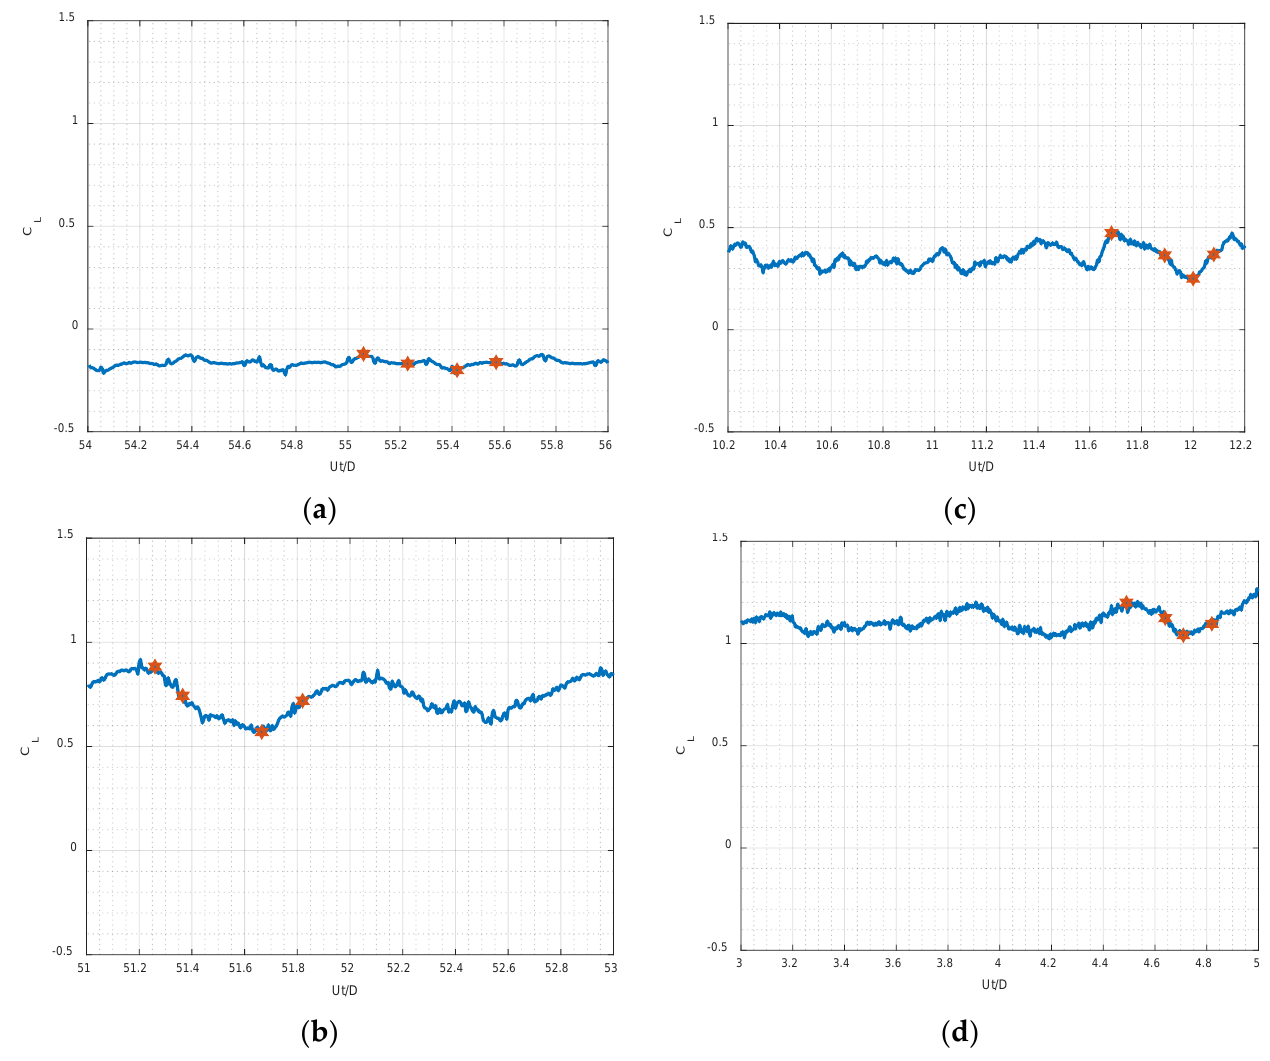
Figure 5. Segments of lift force coefficient time histories simulated using VPM for NACA64 at ( a ) α = 0 ◦ , Re C = 4000, ( b ) α = 10 ◦ , Re C = 4000, ( c ) α = 0 ◦ , Re C = 60,000, and ( d ) α = 10 ◦ , Re C = 60,000. To examine the effects in detail, instantaneous flow fields and surface pressures are examined for α = 0 ◦ and 10 ◦ . For α = 0 ◦ , Figure 6 shows the flow fields at instants Ut / D = 55.06 and 11.68 for Re C = 4000 and 60,000, respectively, which correspond to the instants labeled by the first red stars in Figure 5c. For the low Reynolds number case, the vorticity (Figure 6a) develops from the windward portion of the body wall, indicating the growth of laminar boundary layers in this region. At approximately 60% of the chord, the flow and the vorticity separate, feeding into the wake. The two laminar shear layers of opposite signs interact downstream and a Karman-type of wake forms at around 20% of the chord length downstream of the trailing edge. For the high Reynolds number case (Figure 6b), the upstream boundary layers become thinner. The higher inertia of the ambient flow forces the separation point to move slightly downstream to about 65% of the chord. Instantaneous separation bubbles form and the shear layers roll up to vortices of about 70~80% of the